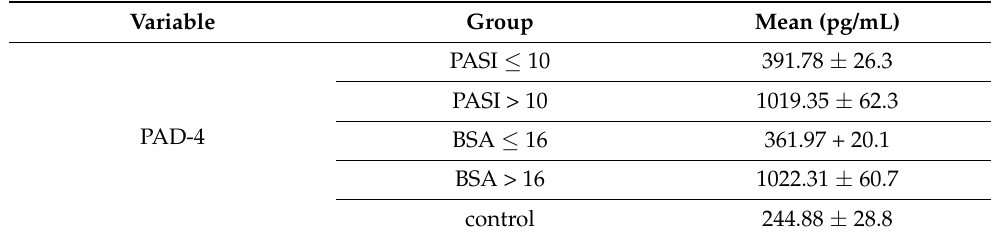
Table 6. Pre-treatment levels of PAD-4 (pg/mL) in patients with plaque psoriasis ( n = 50) with PASI score ≤ 10 ( n = 12), PASI > 10 ( n = 38), BSA ≤ 16 ( n = 12), BSA > 16 ( n = 38) and in the control group ( n =